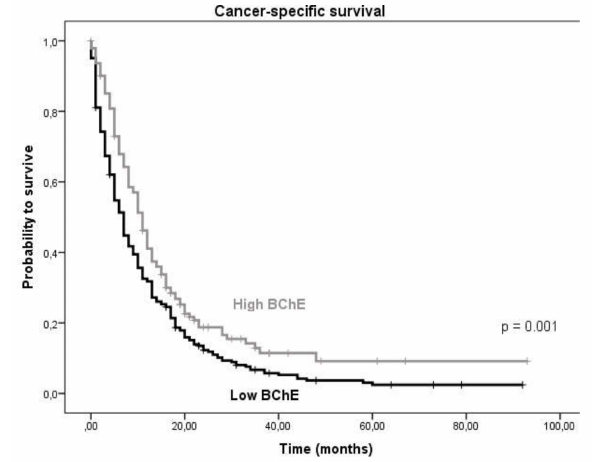
Figure 1. CSS (cancer-specific survival) in patients with low BChE activity vs. high BChE activity. By using the calculated optimized cut o ff values for all laboratory variables, we found bilirubin (hazard ratio: 0.746, 95% confidence interval: 0.610–0.913, p = 0.004), GGT (hazard ratio: 1.443, 95% confidence interval: 1.093–1.905, p = 0.010), ALT (hazard ratio: 0.791, 95% confidence interval: 0.658–0.951, p = 0.013), ALP (hazard ratio: 1.440, 95% confidence interval: 1.101–1.884, p = 0.008) and BChE (hazard ratio: 1.406, 95% confidence interval: 1.129–1.754, p = 0.002) to show a significant